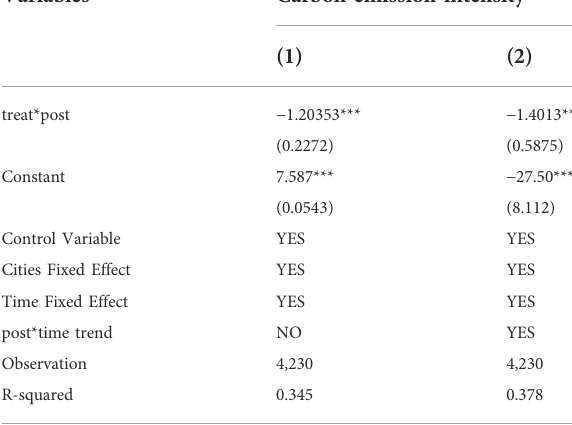
TABLE 3 Benchmark